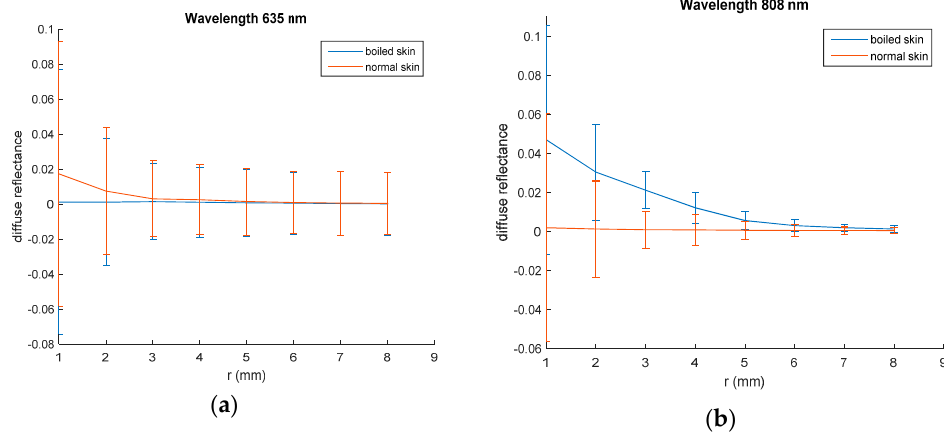
Figure 5. Spatially resolved steady state diffuse reflectance of normal and boiled breast chicken skin: ( a ) at 635 nm; ( b ) at 808 nm laser irradiation.